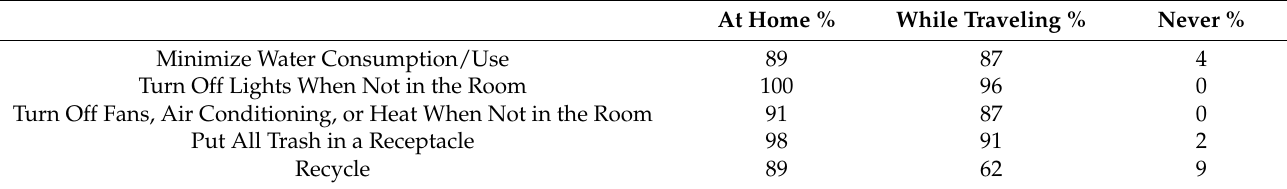
Table 4. Comparison of tourist behavior while at home and while traveling. At Home % While Traveling % Never